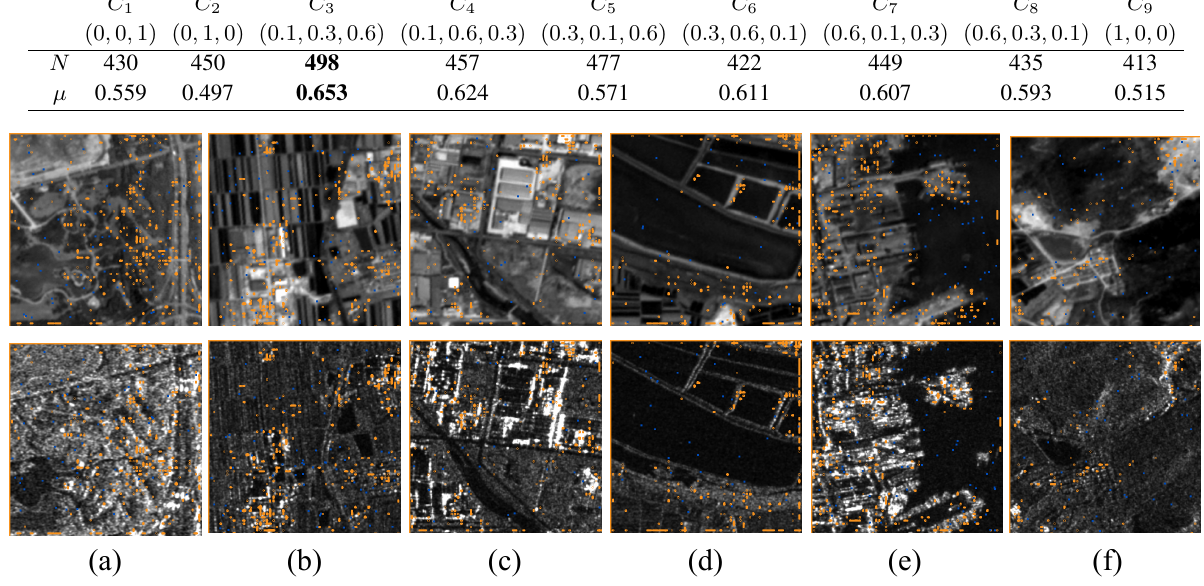
Figure 5. Keypoint detection results. (a), (b), (c), (d), (e) and (f) are six pairs of images covered with different scenes including: urban, suburban, industrial, pond, port, and mountain, where the first row are optical image and the second row are SAR images. Each pair of images is pixel-aligned and has a size of 240 × 240, where the yellow points indicate repeatable keypoints, and conversely blue points indicate non-repeatability. Table 3. The result of keypoint repeatability. I 1 , I 2 , I 3 , I 4 , I 5 , I 6 are urban, suburban, industrial, pond, port and mountain scenes respectively, where ASIFT is the abbreviation of